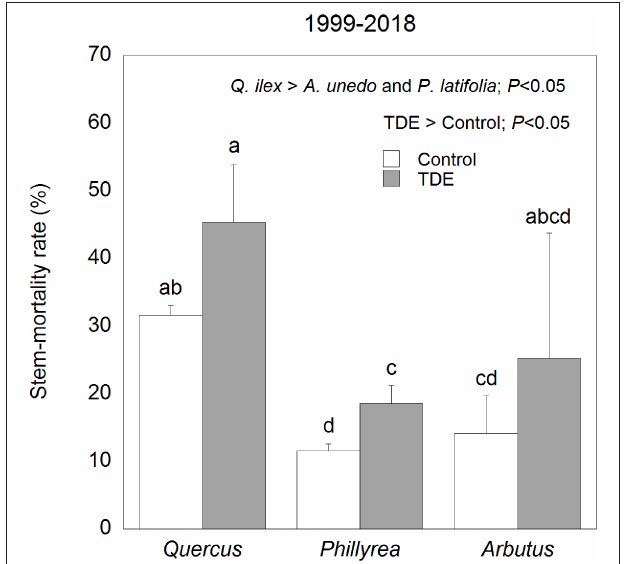
FIGURE 5 | Average stem-mortality rates in the control and TDE plots for each of the three species studied. Error bars correspond to the standard error of the mean ( n = 4). Different letters indicate significant differences ( P < 0.05).